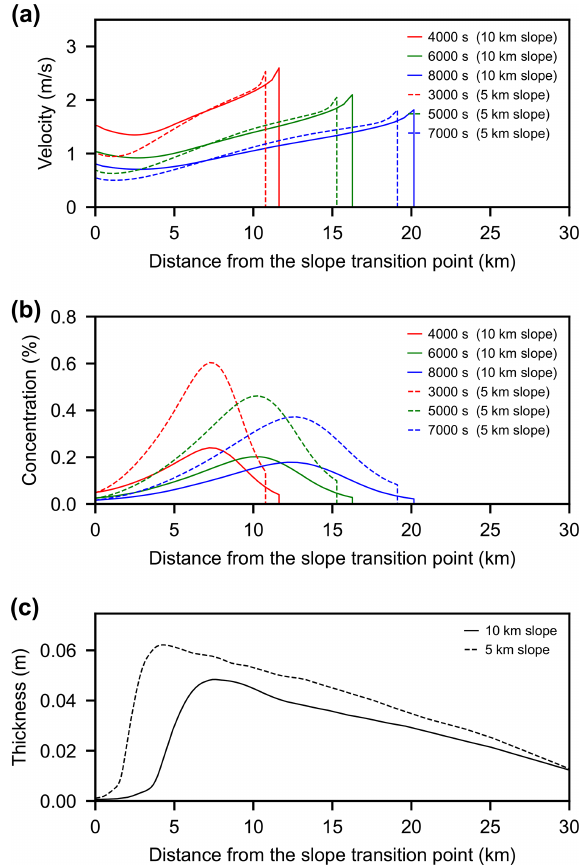
Figure 12. Influence of the length of the upstream slope on the re- sult of inverse analysis. A 10km long slope was used to produce a turbidite, and the bed was analyzed by the inverse model trained with a 5km long upstream slope. Solid lines are values for currents producing the bed, and the dashed lines are reconstructed values. (a) Time development of flow velocity. (b) Total sediment concen- tration. (c) Distribution of bed